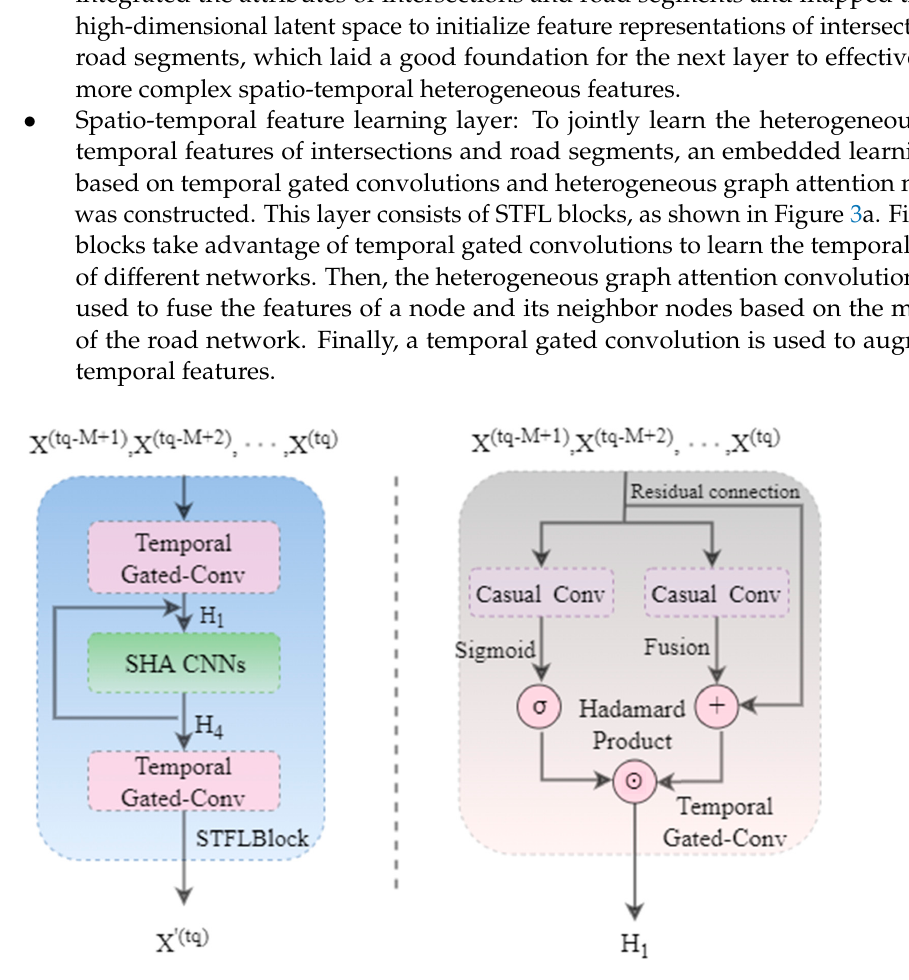
Figure 3. Spatio-Temporal Heterogeneous Graph Learning Layer.